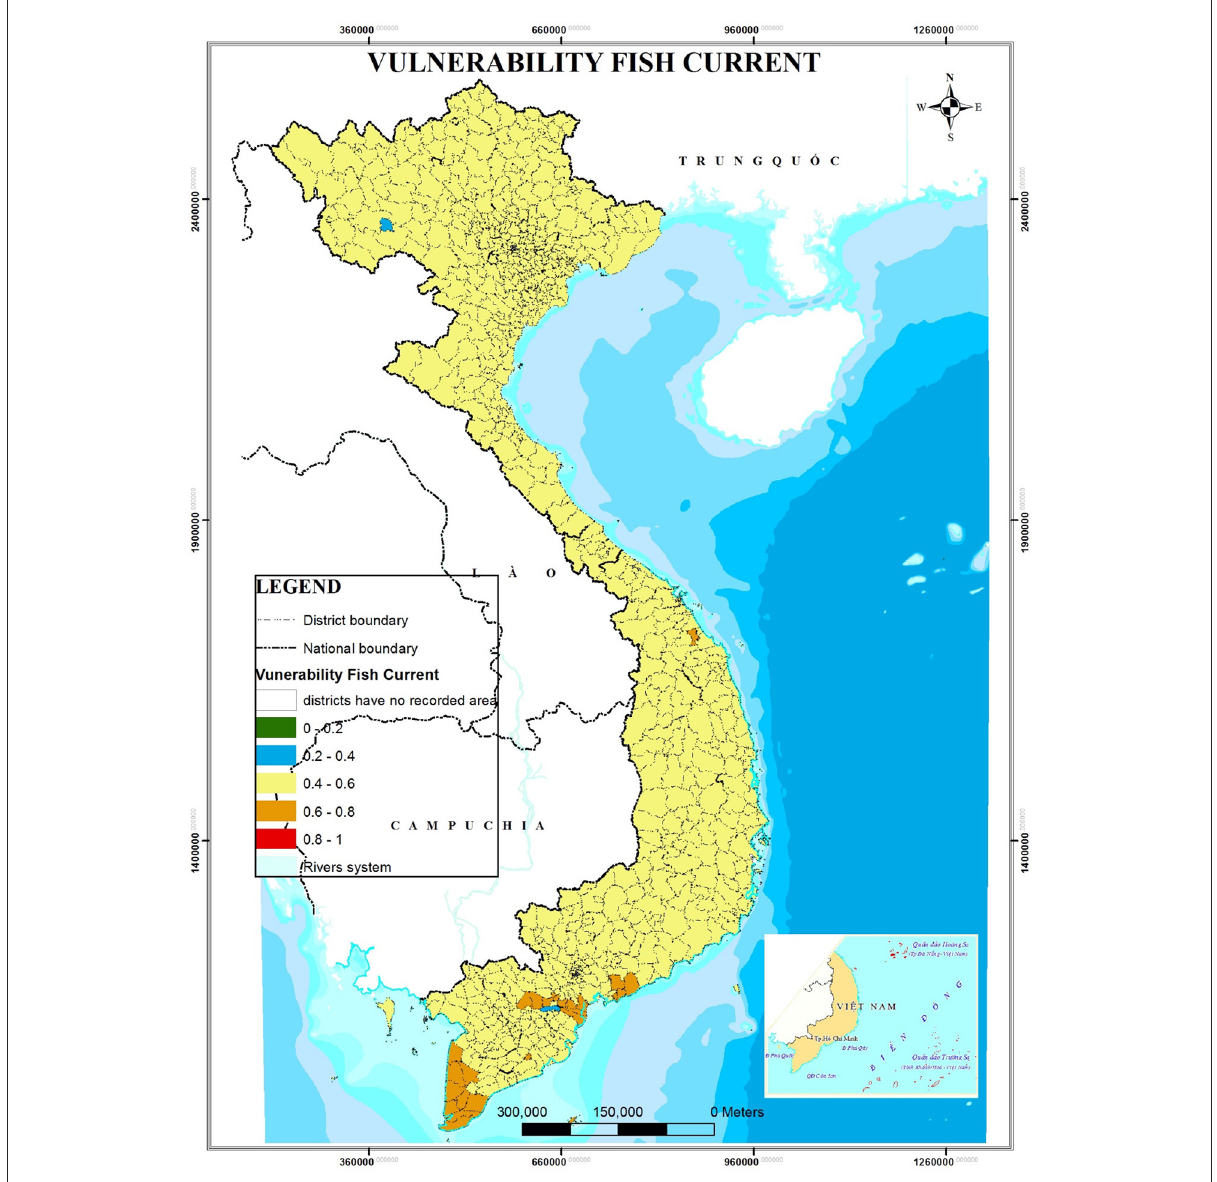
FIGURE4 Vulnerable level of fish farming to climate change. Source: Cao et al. (2018).